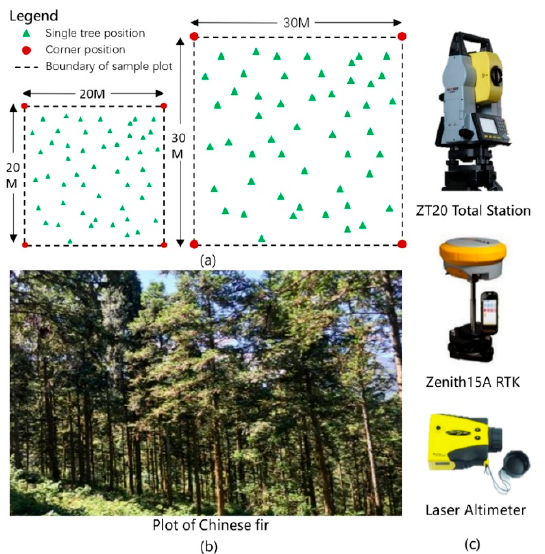
Figure A1. ( a ) schematics of the 20 m × 20 m and 30 m × 30 m sample plots; ( b ) a photo of a ground measured Chinese fir plot; ( c ) the equipment used for sample plot locating and tree height measurement.